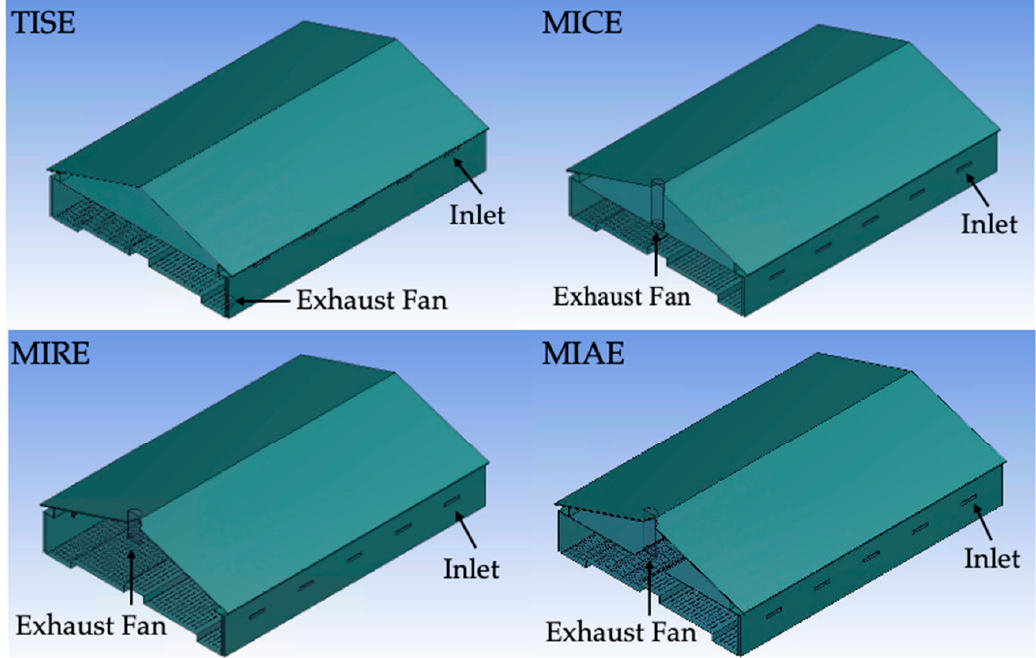
Figure 1. Diagrams of the study hen house with four ventilation configurations (the standard, TISE, and three alternative designs: MICE, MIRE, and MIAE) and annotations indicating the position of inlets and the exhaust fan.